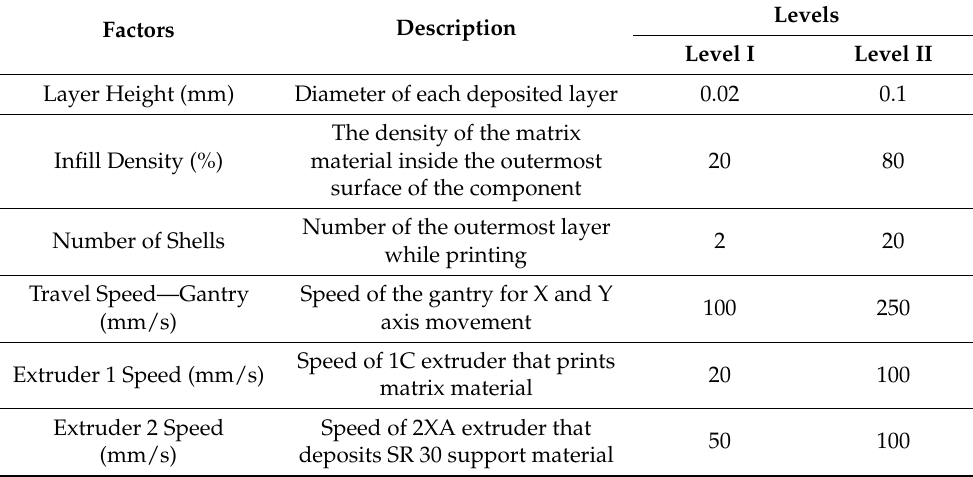
Table 1. Independent parameters at two